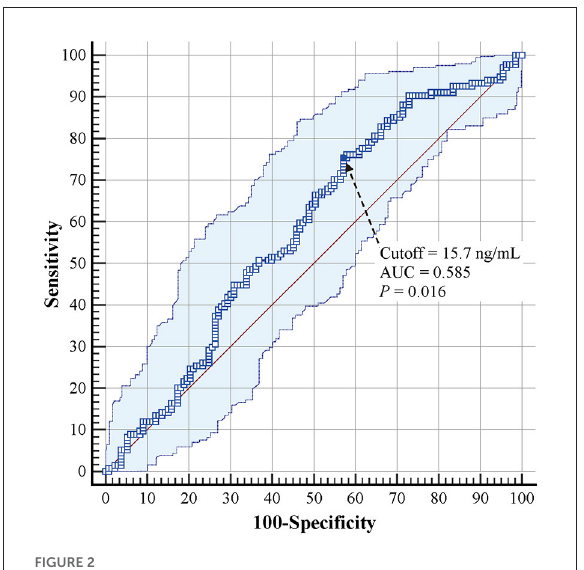
FIGURE2 Receiver operating characteristic curves for cord-blood 25(OH)D levels in predicting BPD development in VLBW and ELBW preterm infants. BPD, bronchopulmonary dysplasia; VLBW, very low birth weight; ELBW, extremely low birth